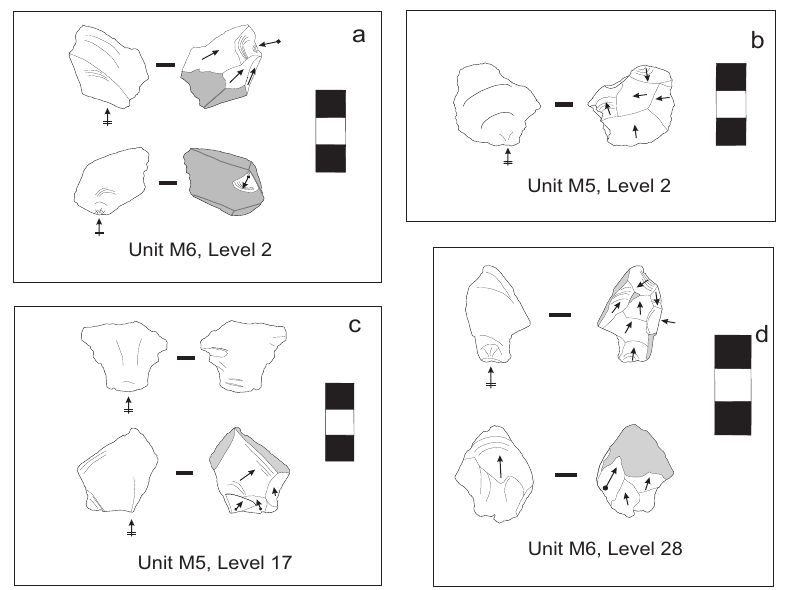
Figure 6 - Flakes found at different stratigraphic positions, all showing the same general technological characteristics. a : Flakes on quartz crystal, Level 2, later than 4200 cal BP; b : Flake on quartz crystal, Level 2, later than 4200 cal BP; c : Flake on quartz crystal, Level 17, ca. 9500 cal BP; d : Flakes on quartz crystal, Level 28, ca. 10,000 cal